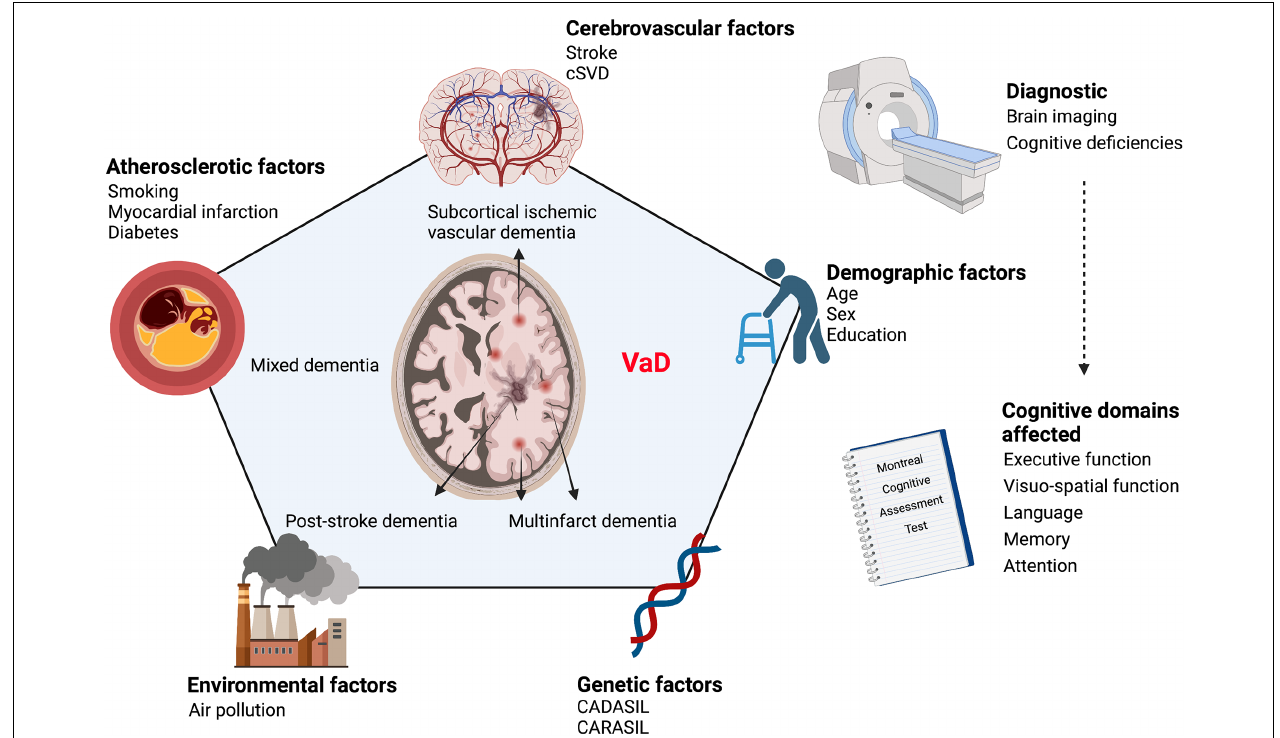
FIGURE 1 | Scheme illustrating the continuum of risk factors that contribute to VaD etiology. VaD emerges as a conjunction of various risk factors affecting vascular homeostasis, namely cerebrovascular diseases, atherosclerosis, genetic and environmental factors. VaD diagnosis is based on the evaluation of cognitive deficiencies combined with neuroimaging to detect underlying vascular alterations. VaD, vascular dementia; CADASIL, cerebral autosomal dominant arteriopathy with subcortical infarcts and leukoencephalopathy; CARASIL, cerebral autosomal recessive arteriopathy with subcortical infarcts and leukoencephalopathy; cSVD, cerebral small vessel disease. Created with